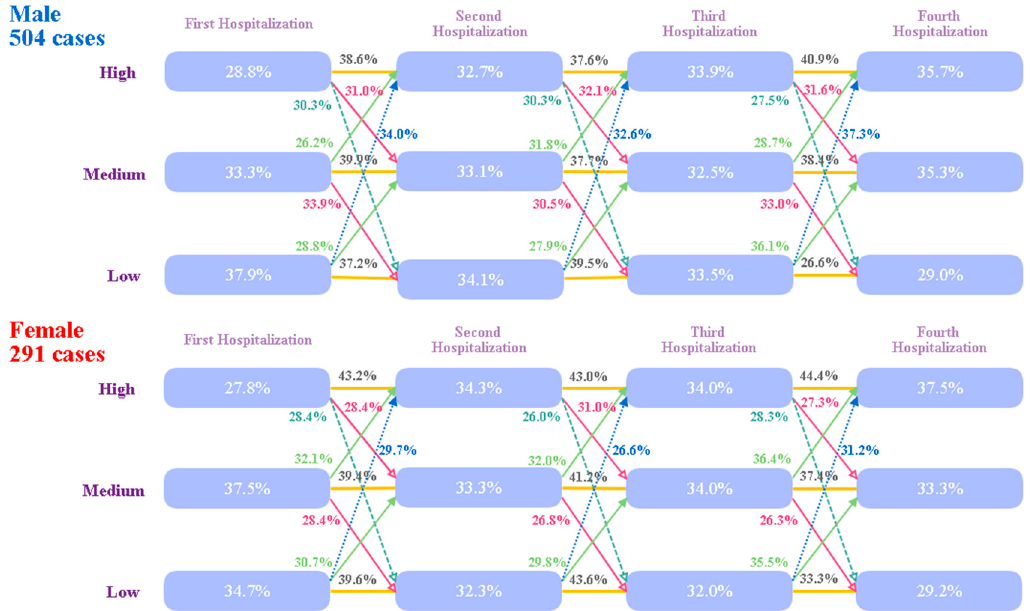
Figure 2. Group-based trajectory model (GBTM) of medical expenditure of stroke patients of different genders. Patients were divided into three groups according to medical expenditure, high, medium, and low groups, separated at the 33rd and the 66th percentiles. The trend of movement of patients to groups of higher medical expenditure was observed in both genders.